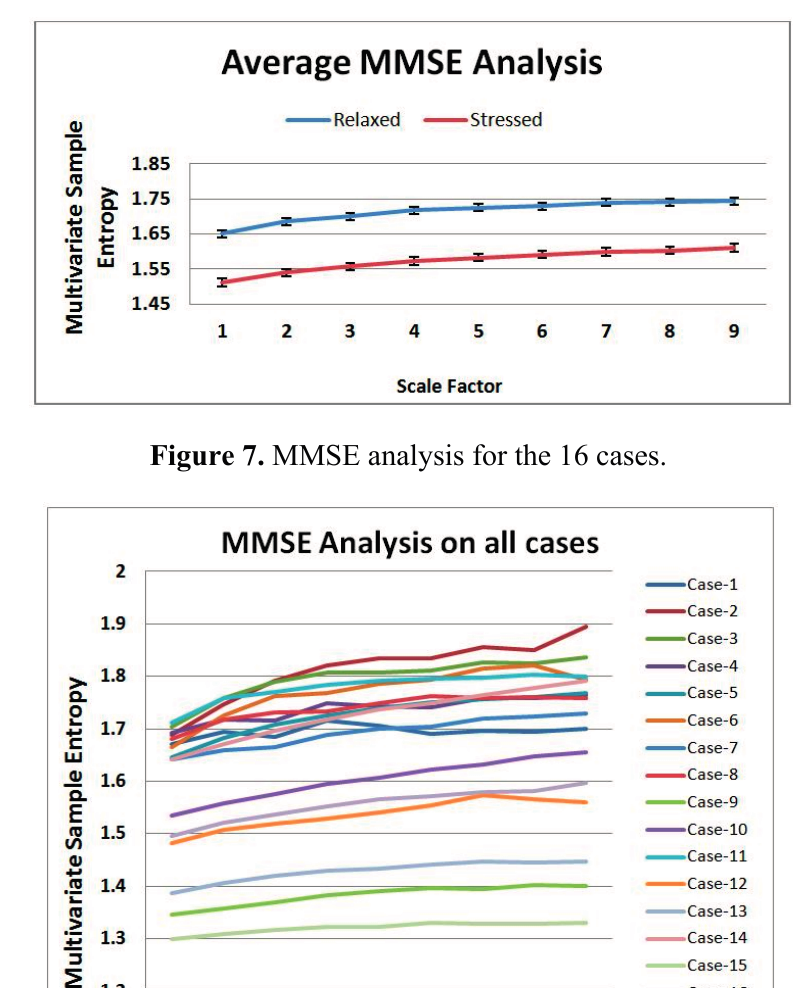
Figure 6. Average of the MMSE analysis with the standard deviation error bars for 8 Relaxed and 8 Stressed cases.